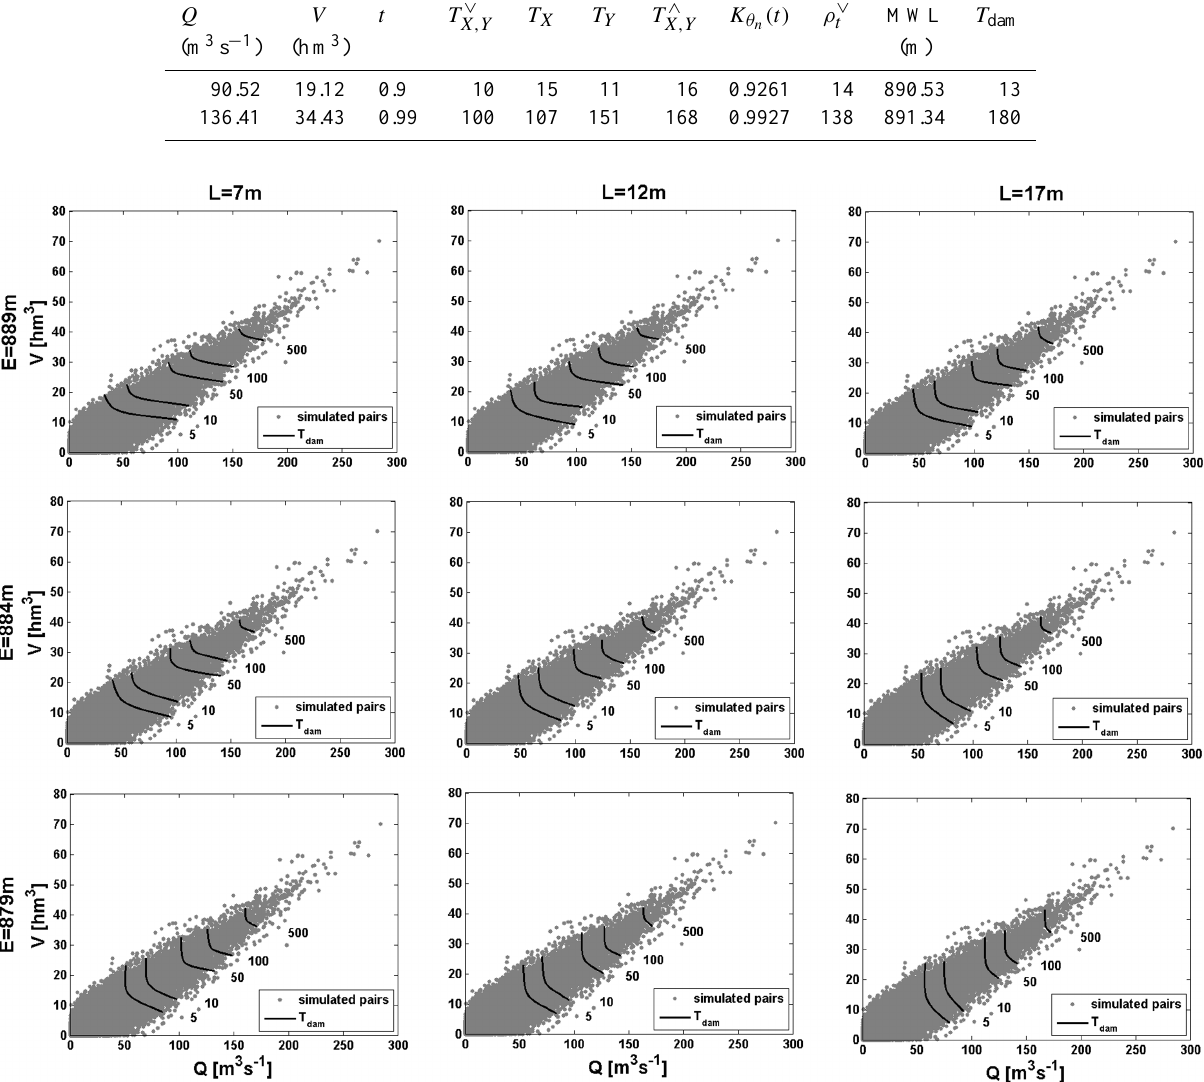
Fig. 11. Comparison among return period curves related to the risk to the dam depending on the reservoir volume and the spillway